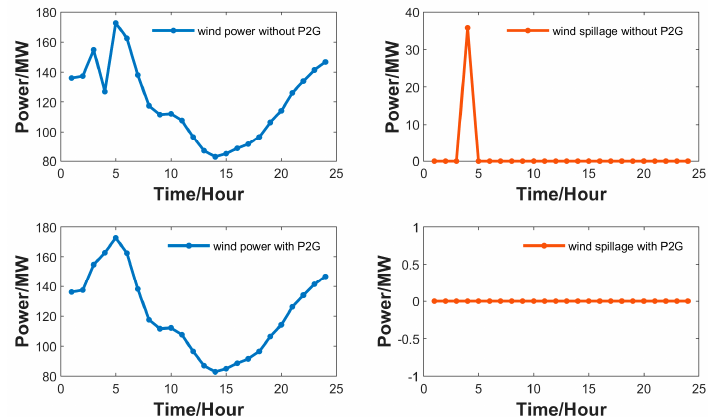
Figure 4. Wind power output and wind spillage in Case 1 and Case